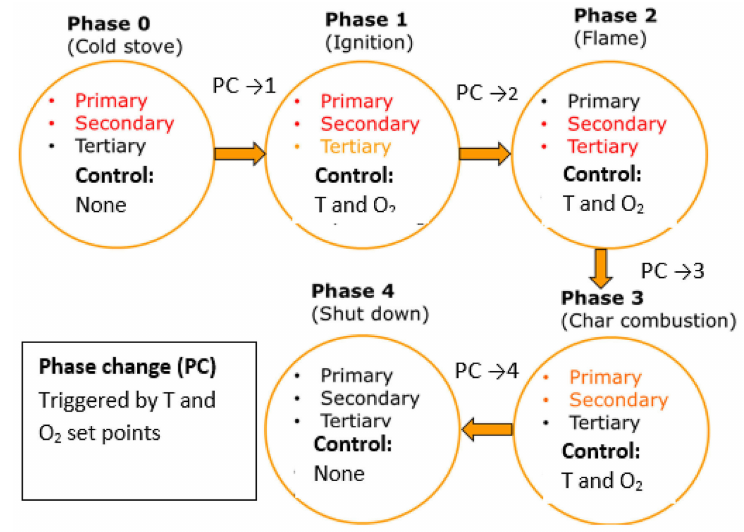
Figure 8. The software regulation concept of the integrated automatic combustion air regulation system based on flue gas temperature and residual oxygen measurements (O 2 ). The color of the type of combustion air (here: primary air supply via grate, secondary air supply as window purge air and tertiary air from nozzles on the back wall of the combustion chamber) indicates the amount of air introduced. Red: high amount, orange: low amount, black: closed. [53]. Reprint with permission from J.B. Illerup, B.B. Hansen, W. Lin, J. Nickelsen, V.H. Pedersen, B. Eskerod, K. Dam-Johansen,